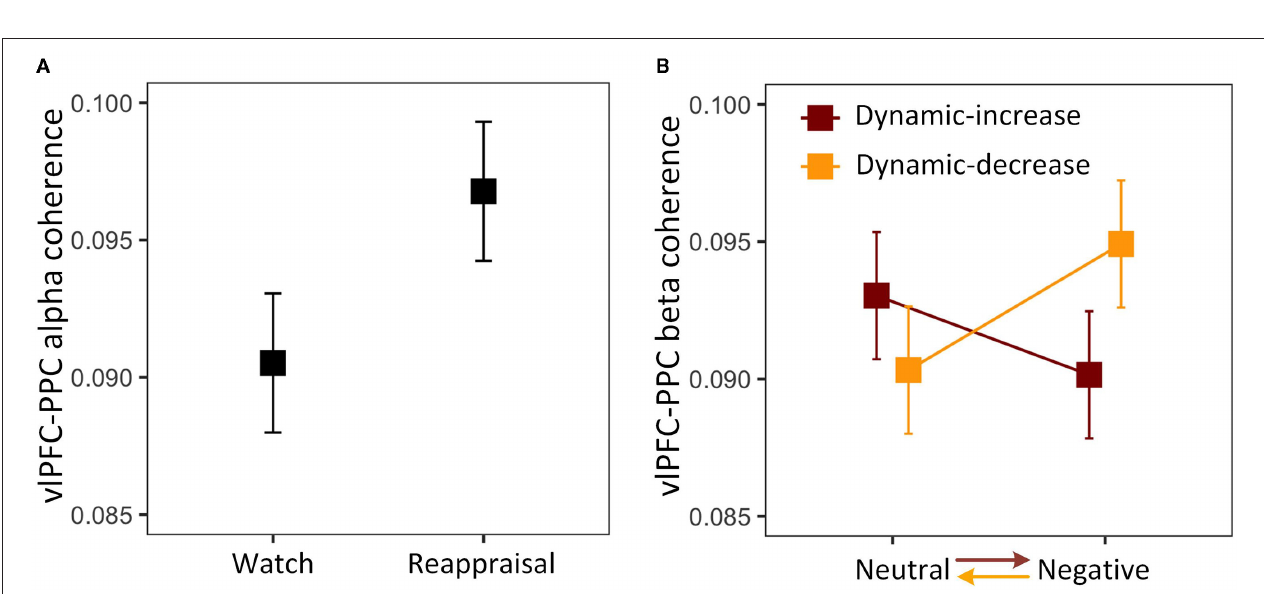
FIGURE 2 | Three-way interaction plot of model estimates of content, context, and task on the (A) alpha band FC between the ventromedial prefrontal cortex (vmPFC) and the anterior cingulate cortex (ACC) and (B) beta band FC between vmPFC and ACC. Error bars are standard errors.